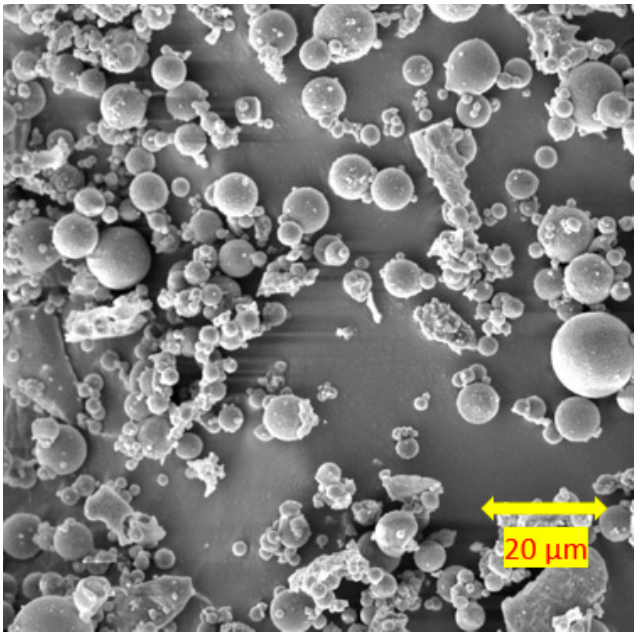
Figure 2. SEM image of fly ash at 20 μ m.